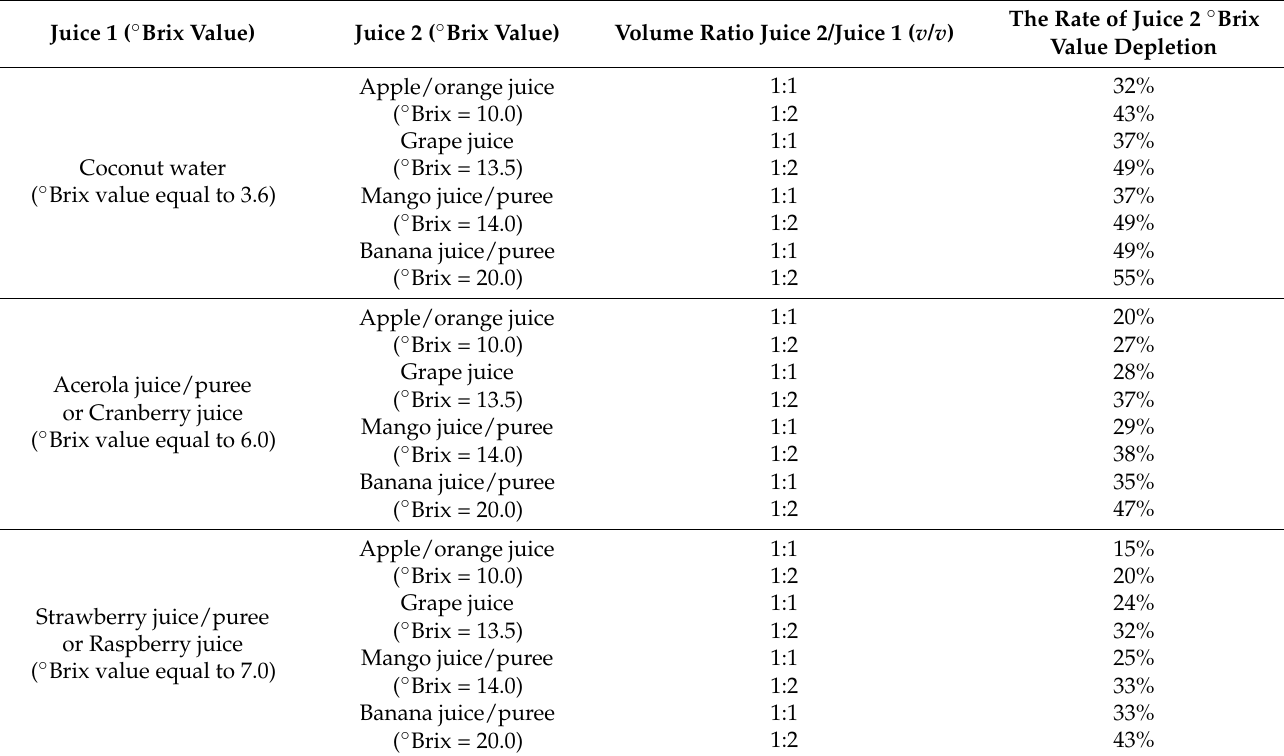
Table 1. Comparison of sugar reduction levels after mixing two different